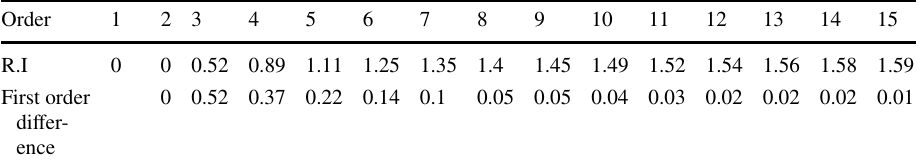
Table 3 Random inconsistency indices for n = 15